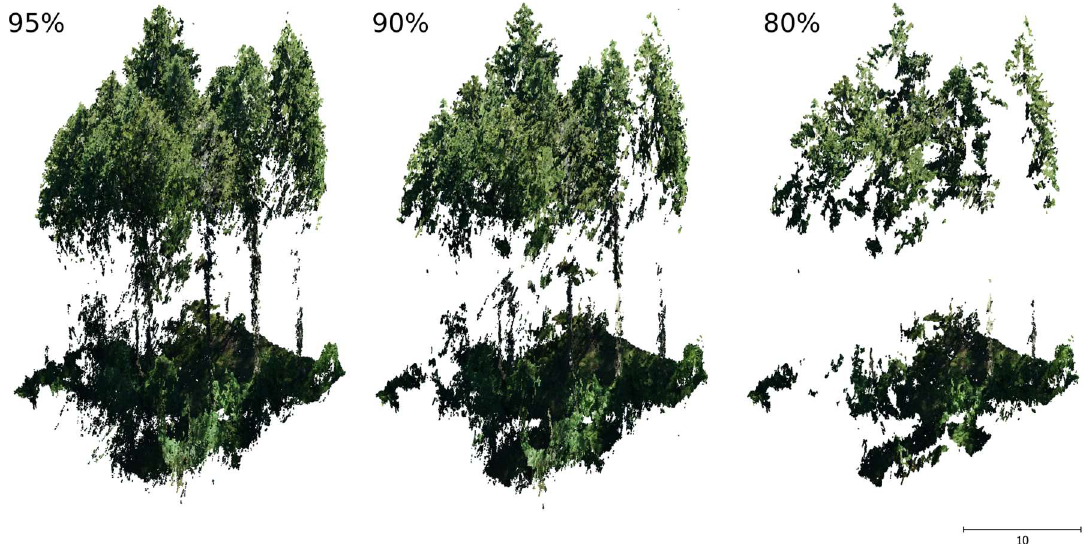
Figure 6. 3D pointcloud scenes of a 20 × 20 m plot employing different image forward overlap scenarios (percentages), showing the consistency of reconstructing points higher in the canopy, with diminishing reconstruction quality in the understory and under obfuscation.